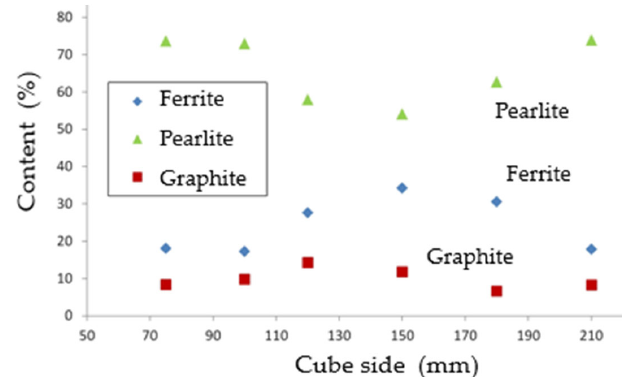
Figure 7. Ferrite, pearlite and graphite average contents of specimens from the same cube side.